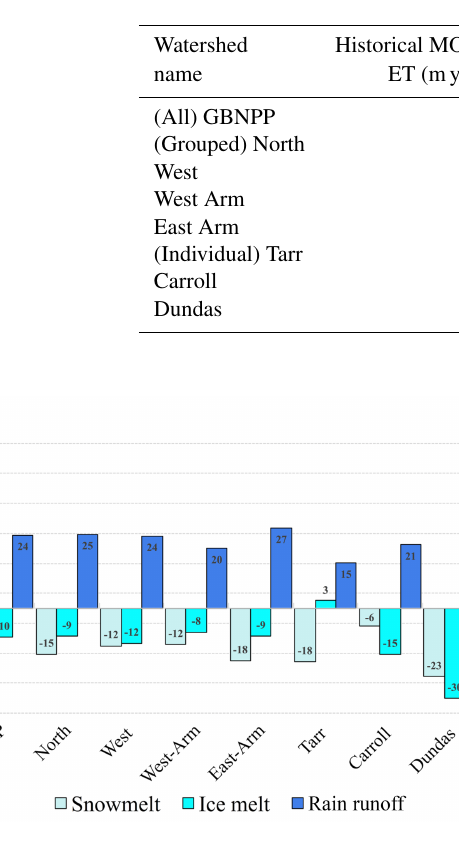
Figure 8. Runoff process change by watershed in the projection sce- nario (RCP 8.5; 2070–2099), partitioned into snowmelt, ice melt, and rain